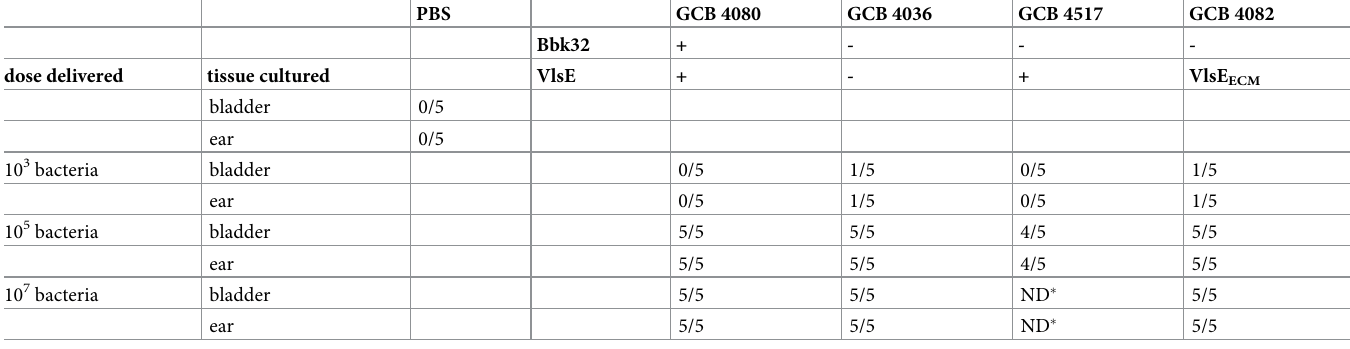
Table 2. Long-term mouse infections with wild-type and vlsE and bbk32 mutants. Infection of SCID mice inoculated with B . burgdorferi strains GCB4036, GCB4080, GCB4082, and GCB4517 (see Table 1) was assessed at three weeks post-inoculation by culture. Shown are the number of mice infected at each of two disseminated sites over the number of mice inoculated for each dose and B. burgdorferi